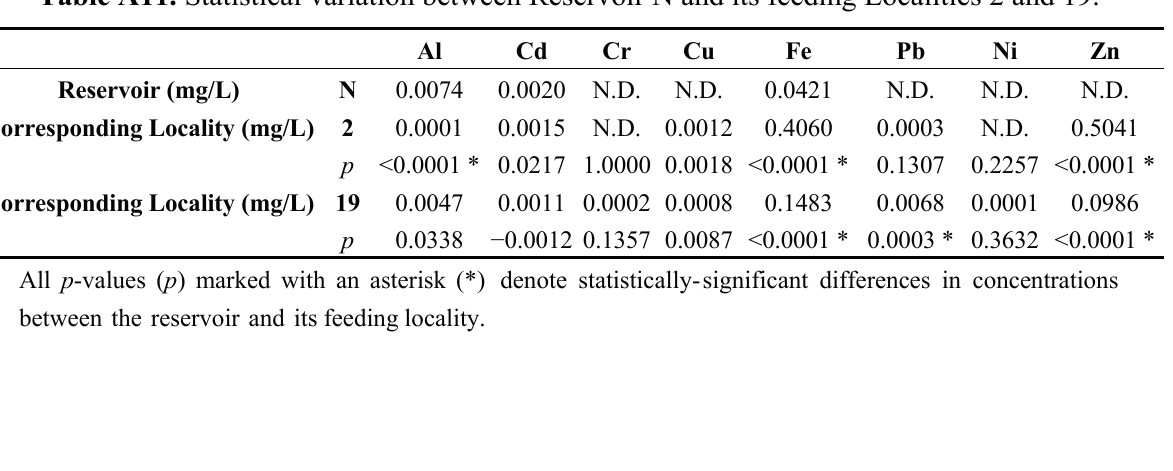
Table A11. Statistical variation between Reservoir N and its feeding Localities 2 and